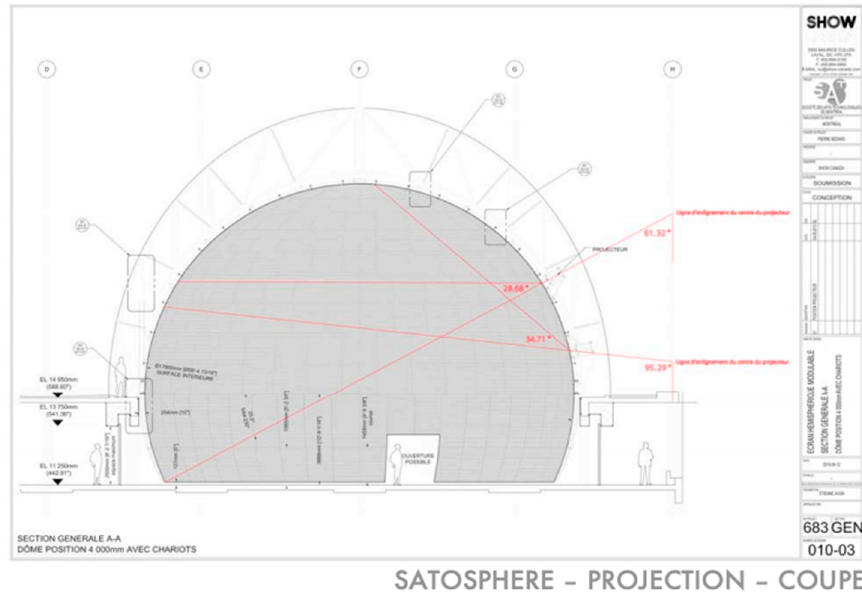
Figure 1. Plan of the dome used for the collective immersion.